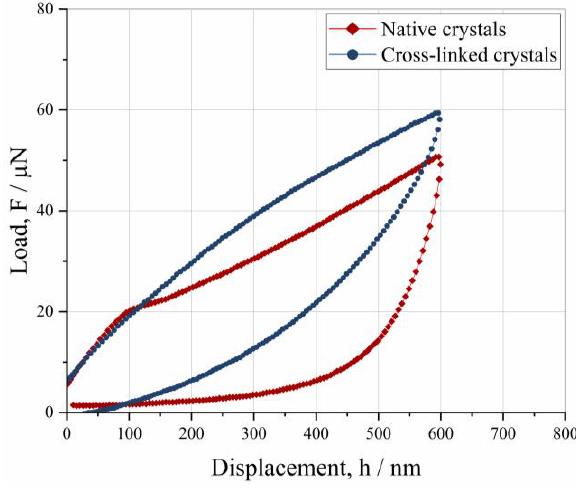
Figure 13. Force – displacement curve comparison of native and cross-linked HheG prismatic faces. Figure 13. Force–displacement curve comparison of native and cross-linked HheG prismatic faces.